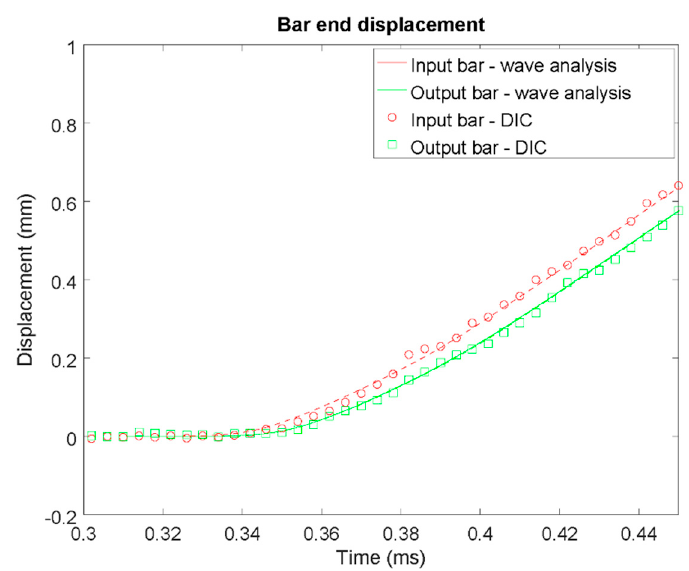
Figure 3. Illustration of the verification of the strain-gauge signal / high speed camera synchronization: bar end displacements obtained from the stress wave analysis and from the high speed footage using digital image correlation. In place of the ice specimens an aluminum cylinder with similar dimensions was used.